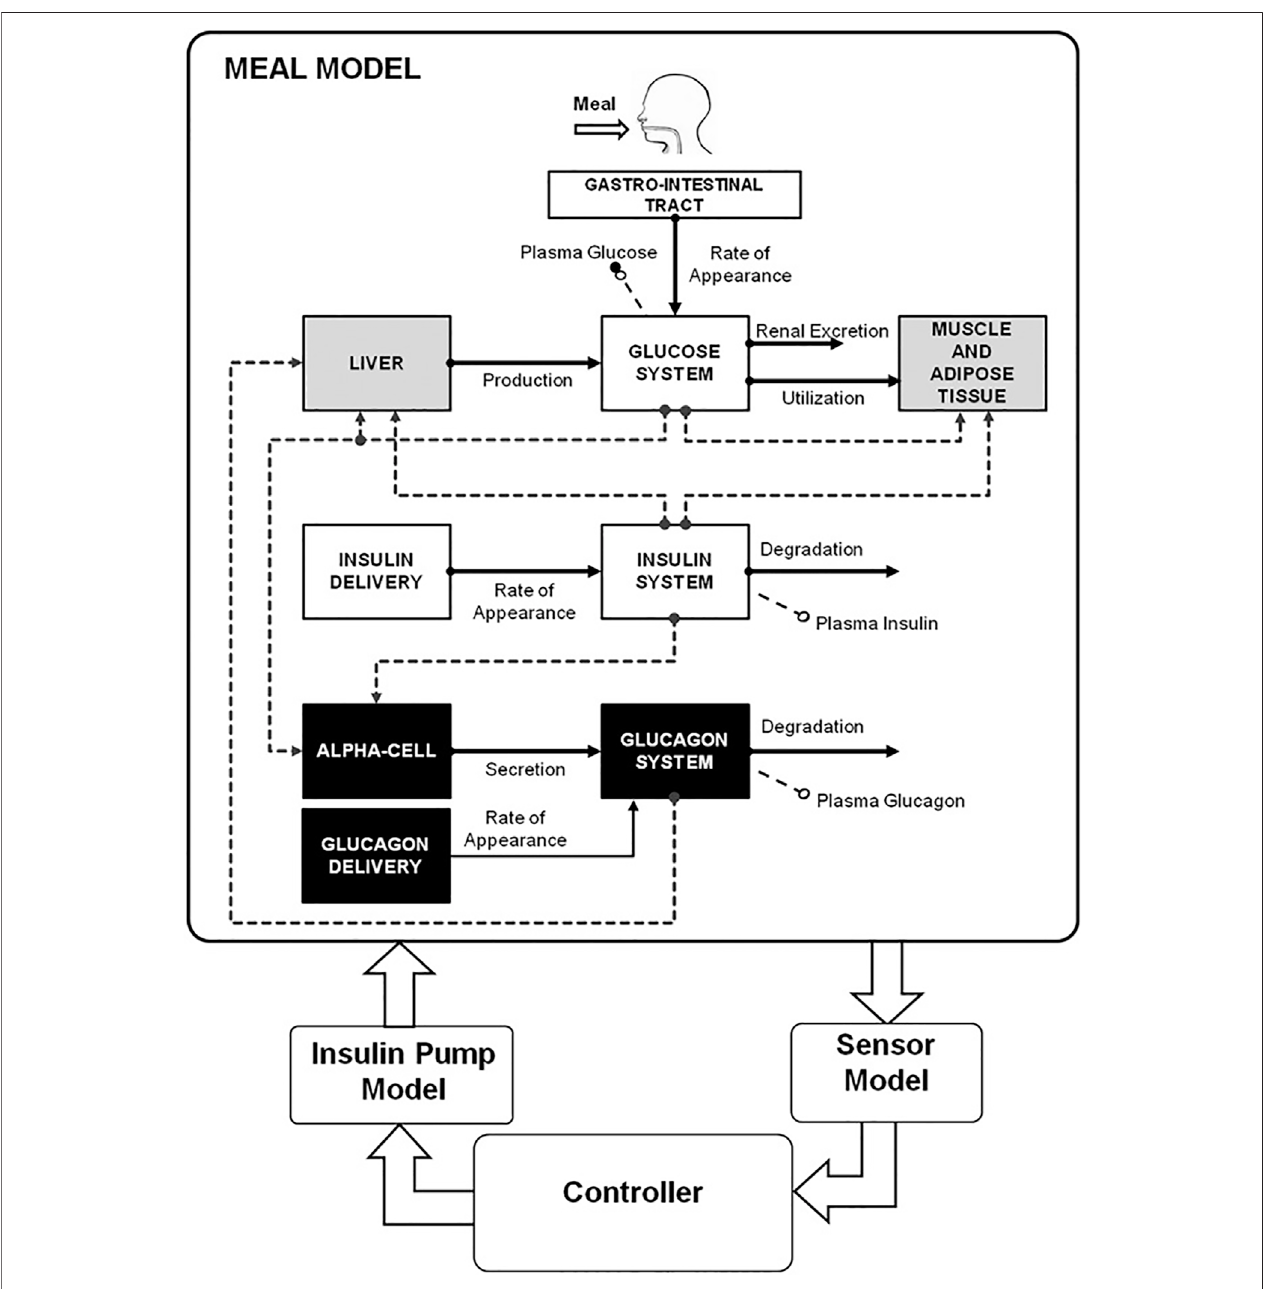
FIGURE 3 | UVA/PADOVA equations,